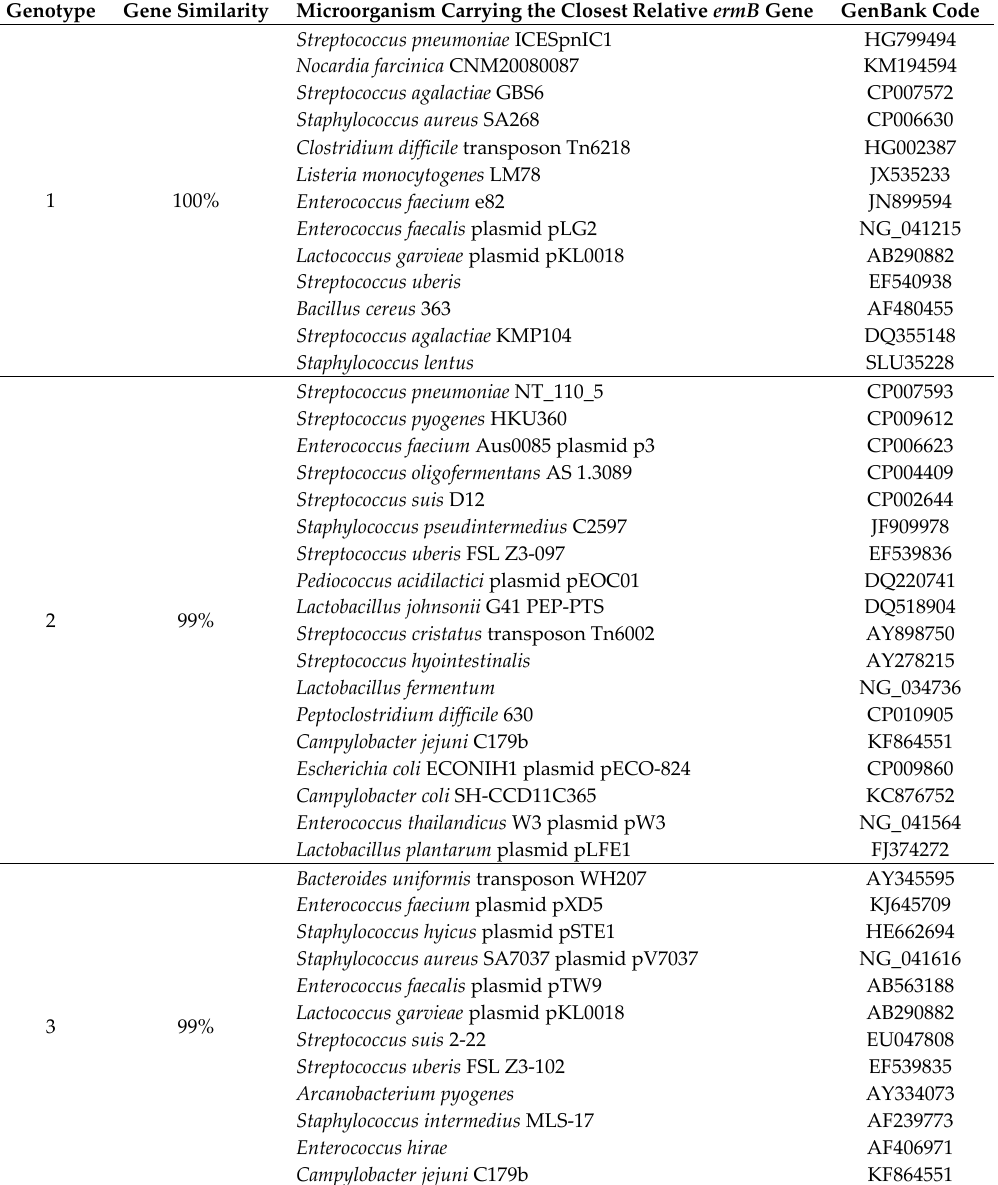
Table 1. Identification of the major ermB genotypes in the WWTP